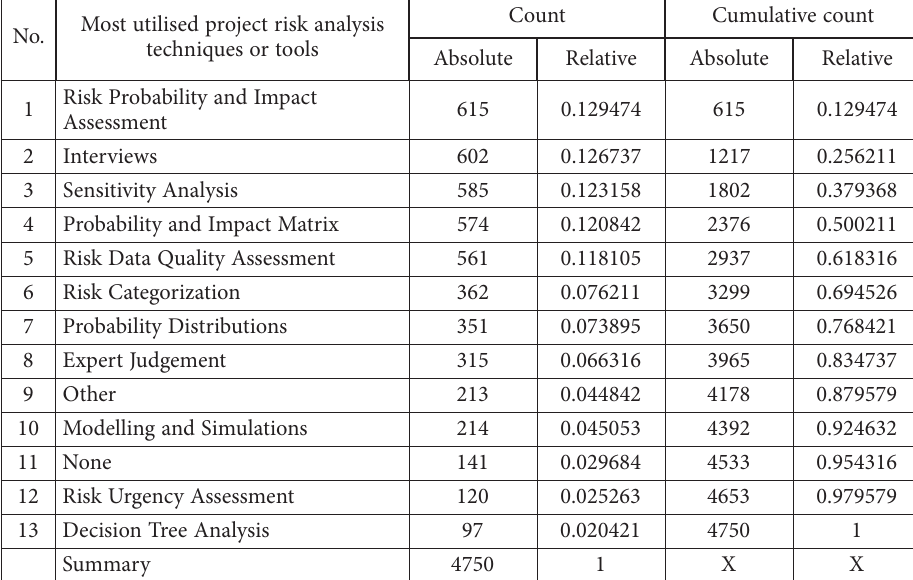
Table 4. Most utilised project risk analysis techniques or tools (n = 1,143) (source: own calculations)